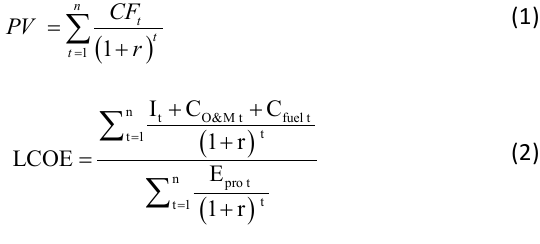
Table 2: Assumptions used in the economic evaluation of power plants in the studied cases